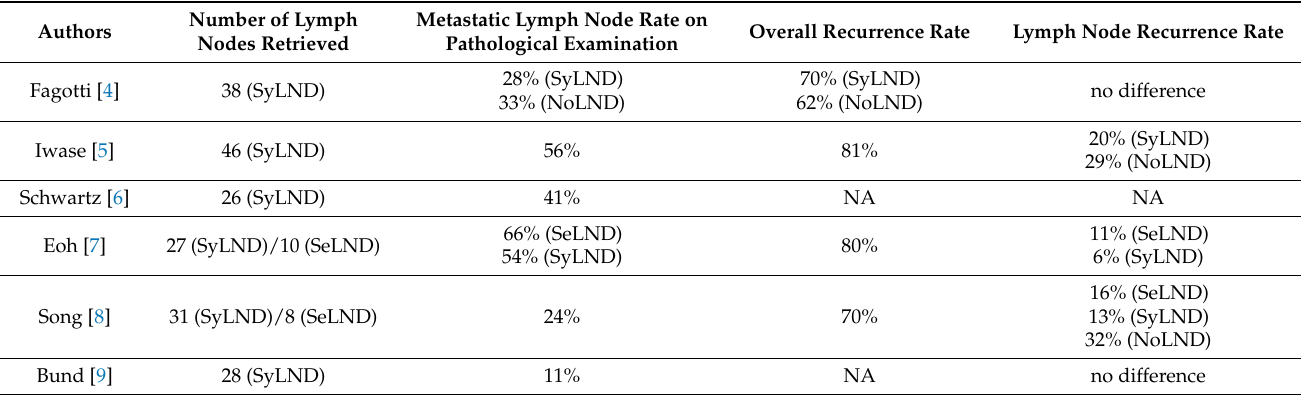
Table 2. Pathological lymph node analysis.